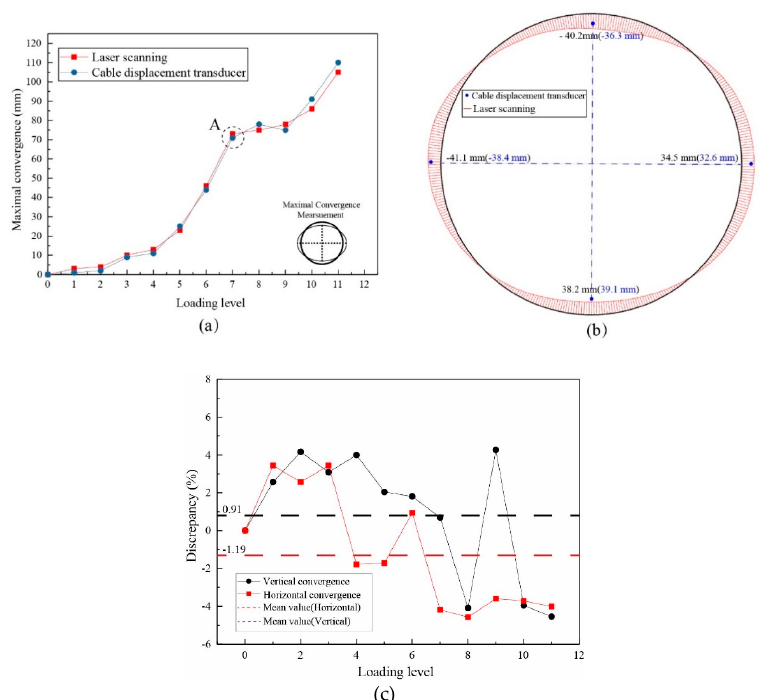
Figure 10. ( a ) Comparison between vertical convergence measured by laser scanning and cable displacement transducer; ( b ) full ring deformation obtained by laser scanning and dispersed deformation obtained by cable displacement transducer at loading stage A (the values in brackets are those measured by cable displacement transducer); and ( c ) the variation of discrepancy at different loading levels.